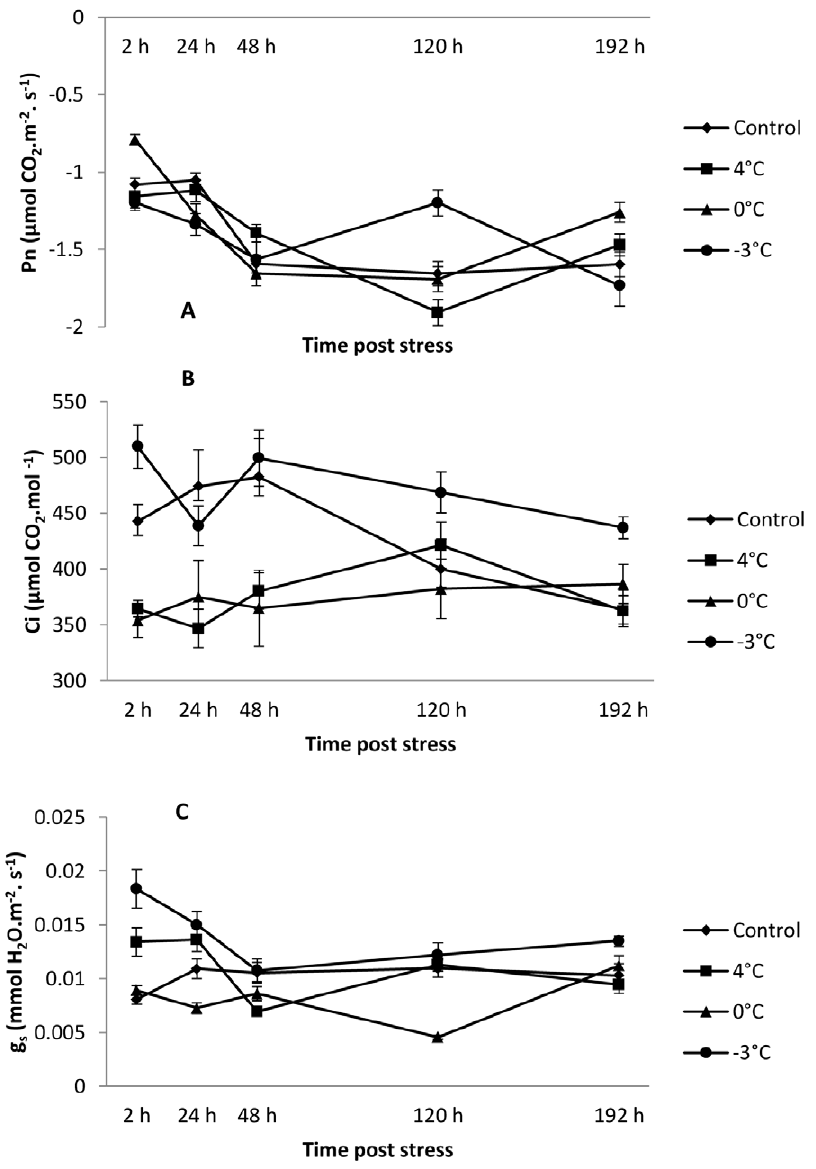
Figure 1. Changes in (A) net photosynthesis (Pn), (B) intercellular CO 2 concentration (Ci) and (C) stomatal conductance (g s ) in control and 4 6 C, 0 6 C or 2 3 6 C-treated inflorescences. Measurements were performed 2, 24, 48, 120 and 192 h after cold treatment. Values are means 6 standard errors (n=45).